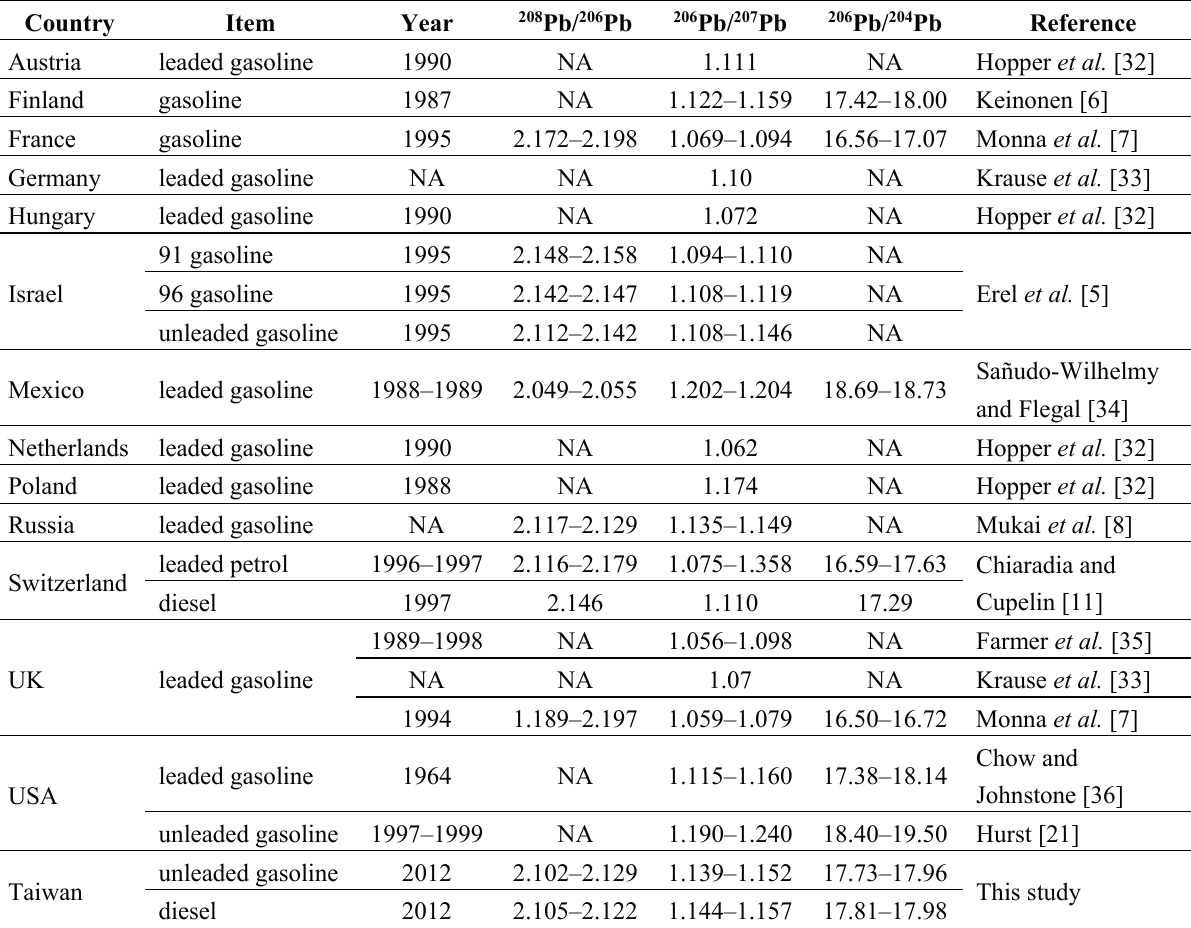
Table 3. Summary of Pb isotopic characteristics in global petroleum